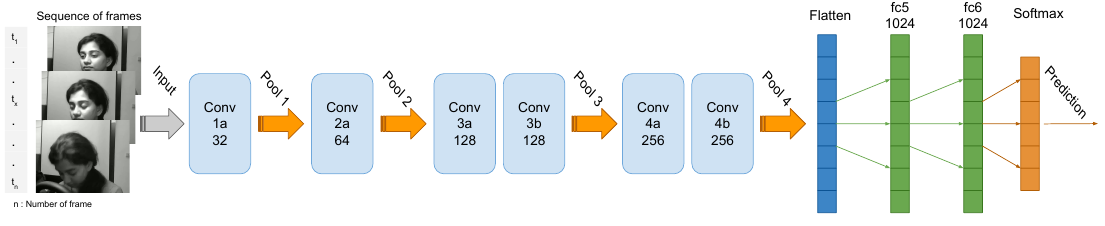
Figure 5. Proposed multi-layer